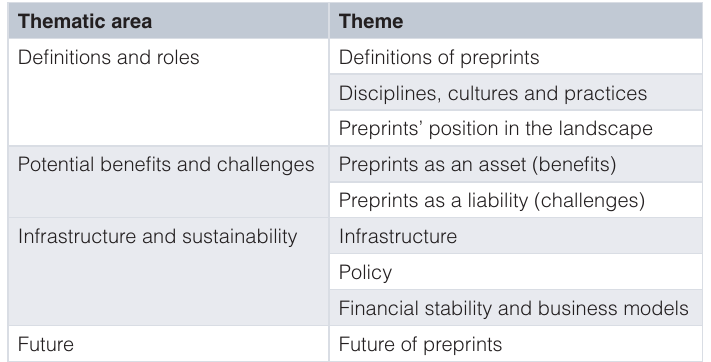
Table 4. Themes from the